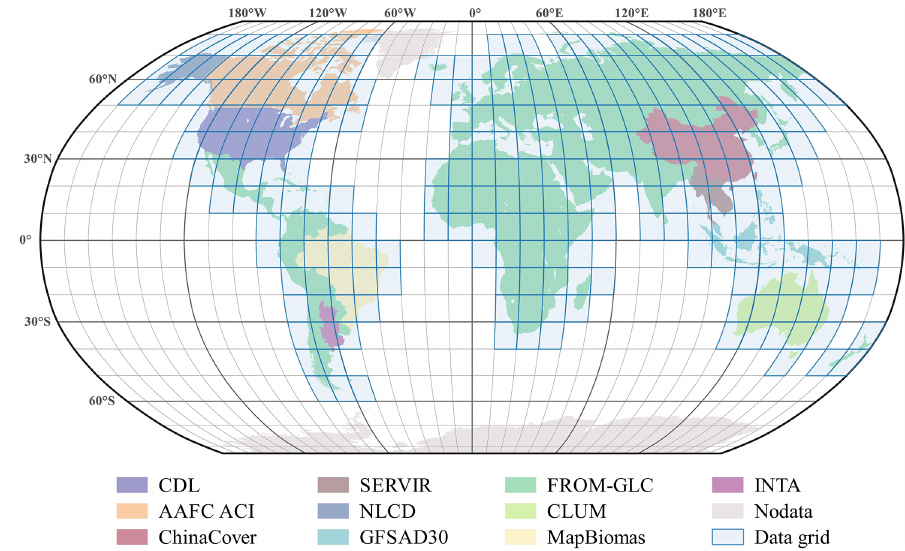
Figure 1. Spatial distribution of the land cover and cropland layer products used for the global 30m cropland extent generation.